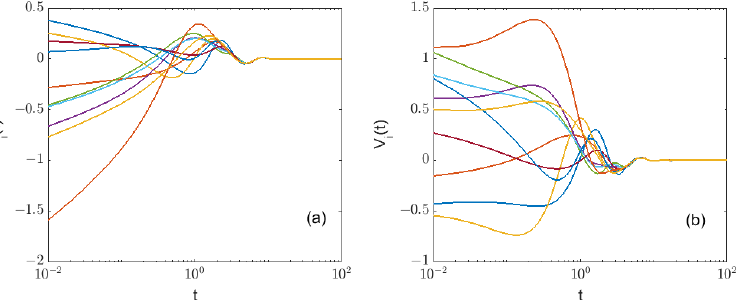
Figure 2. The curves of the position ( a )/velocity ( b ) of each agent as a function of time of FOMAS (3) with different orders p (the case d ≥ 0, c ≥ 0).